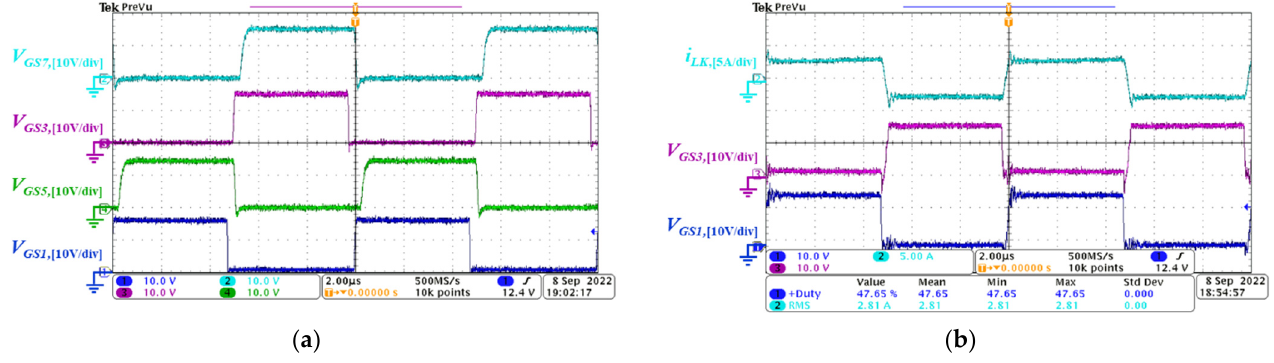
Figure 14. Experimental waveforms of the prototype converter operating in forward power conver- sion mode (at 300 W output power): ( a ) waveforms of gate signals V GS1 , V GS3 , V GS5 and V GS7 ; ( b ) waveforms of gate signals V GS1 , V GS3 and inductor current i LK .